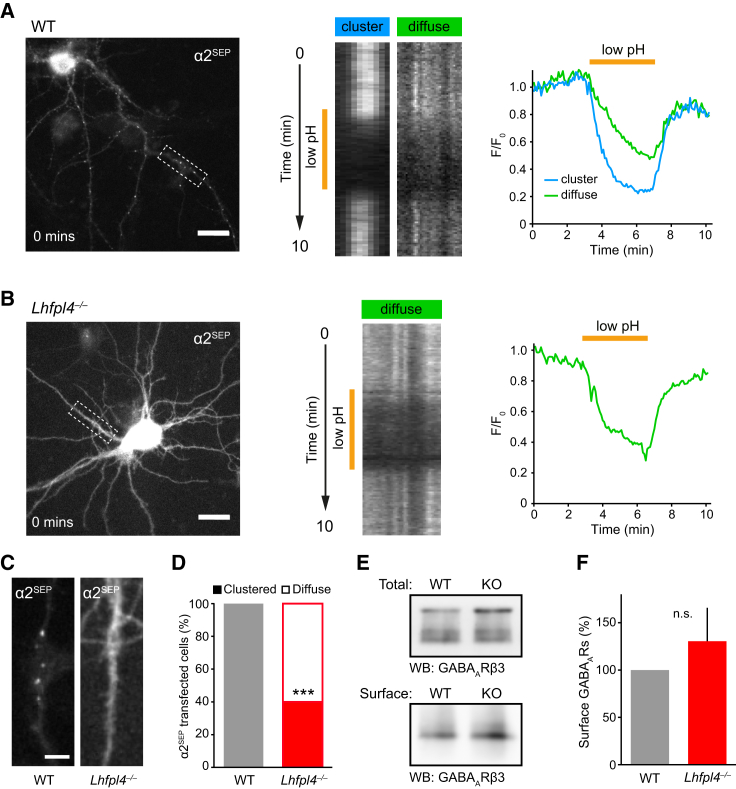
LHFPL4 Is Essential for GABAAR Clustering but Not Their Surface Delivery(A and B) Bright-field images of (A) WT and (B) Lhfpl4−/− hippocampal neurons transfected with super-ecliptic pHlourin-tagged GABAAR-α2 (α2SEP). Kymograph and graph representations of 10-min movies showing pH-dependent α2SEP clusters or diffuse fluorescence signal from dendrite boxed in image. Fluorescence from dendrites is eclipsed on a transient switch to low-pH imaging solution and returns on a switch back to pH 7.4, indicating that the α2SEP fluorescence signal is from surface receptors. Scale, 20 μm.(C) Dendritic zooms of bright-field images of WT and Lhfpl4−/− hippocampal dendrites transfected with GABAAR-α2SEP. GABAAR-α2SEP-containing receptors do not cluster on the surface of Lhfpl4−/− neurons. Scale, 5 μm.(D) Quantification of GABAAR-α2SEP surface fluorescence as clustered or diffuse (n = 50–53 cells from 3 independent preparations; p < 0.0001, Fisher’s exact test).(E) Surface biotinylations of WT and Lhfpl4−/− neurons analyzed by western blotting with anti-GABAAR-β3.(F) Densiometric quantification showing no significant change in surface GABAAR-β3 normalized to total levels (100% and 130.4% ± 35.4%; n = 11 experiments; p = 0.41, Welch t test).Error bars indicate mean ± SEM. ∗p < 0.05; ∗∗p < 0.01; ∗∗∗p < 0.001.See also Figure S2.